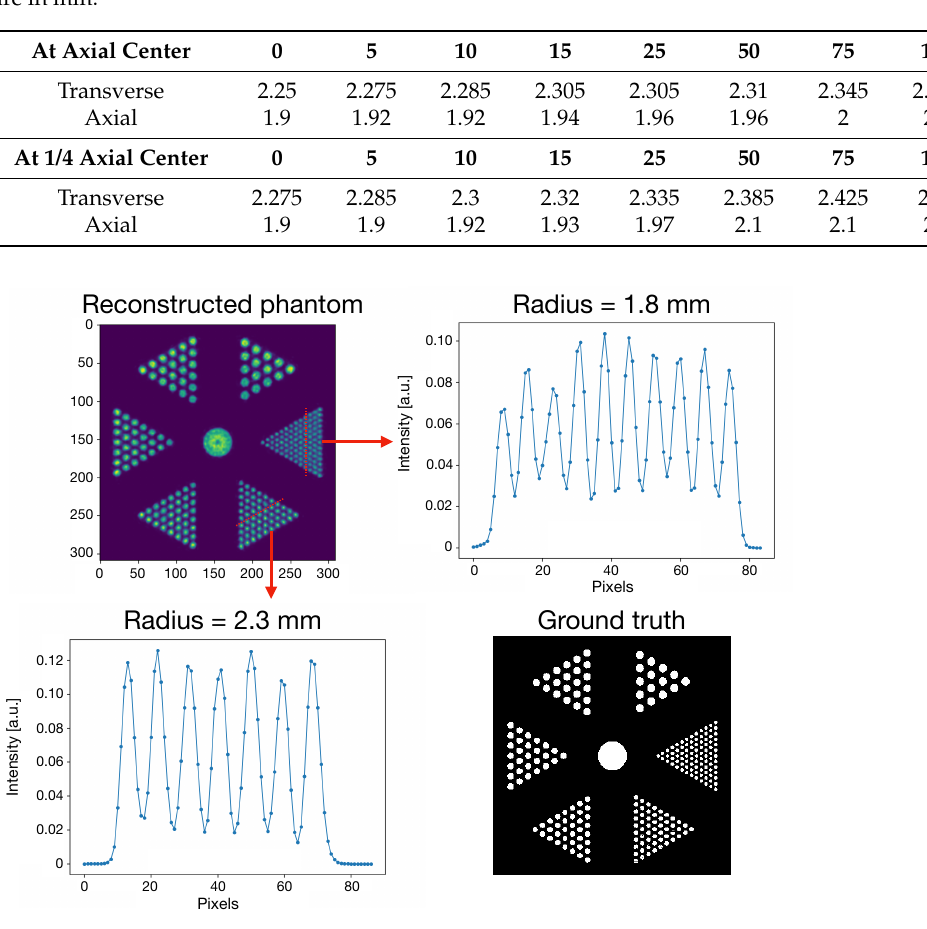
Figure 5. Reconstructed Derenzo Phantom at the 100th iteration number. ( Upper Left ) Reconstructed slice of the phantom. ( Upper Right ) Line profile of the 1.8 mm rods. ( Lower Left ) Line profile of the 2.3 mm rods. ( Lower Right ) Phantom ground truth.